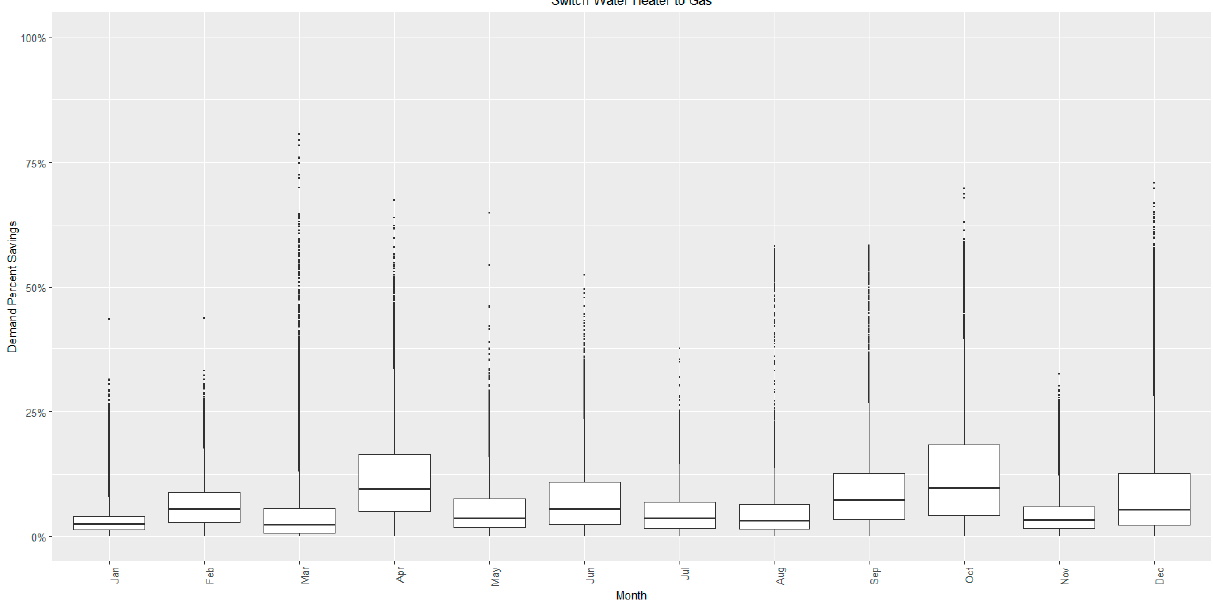
Figure 7. Changing water heaters from electricity to natural gas can relieve peak electric demand. This study found that a building’s demand could be reduced as much as 80% but averages approximately 5% of building peak.